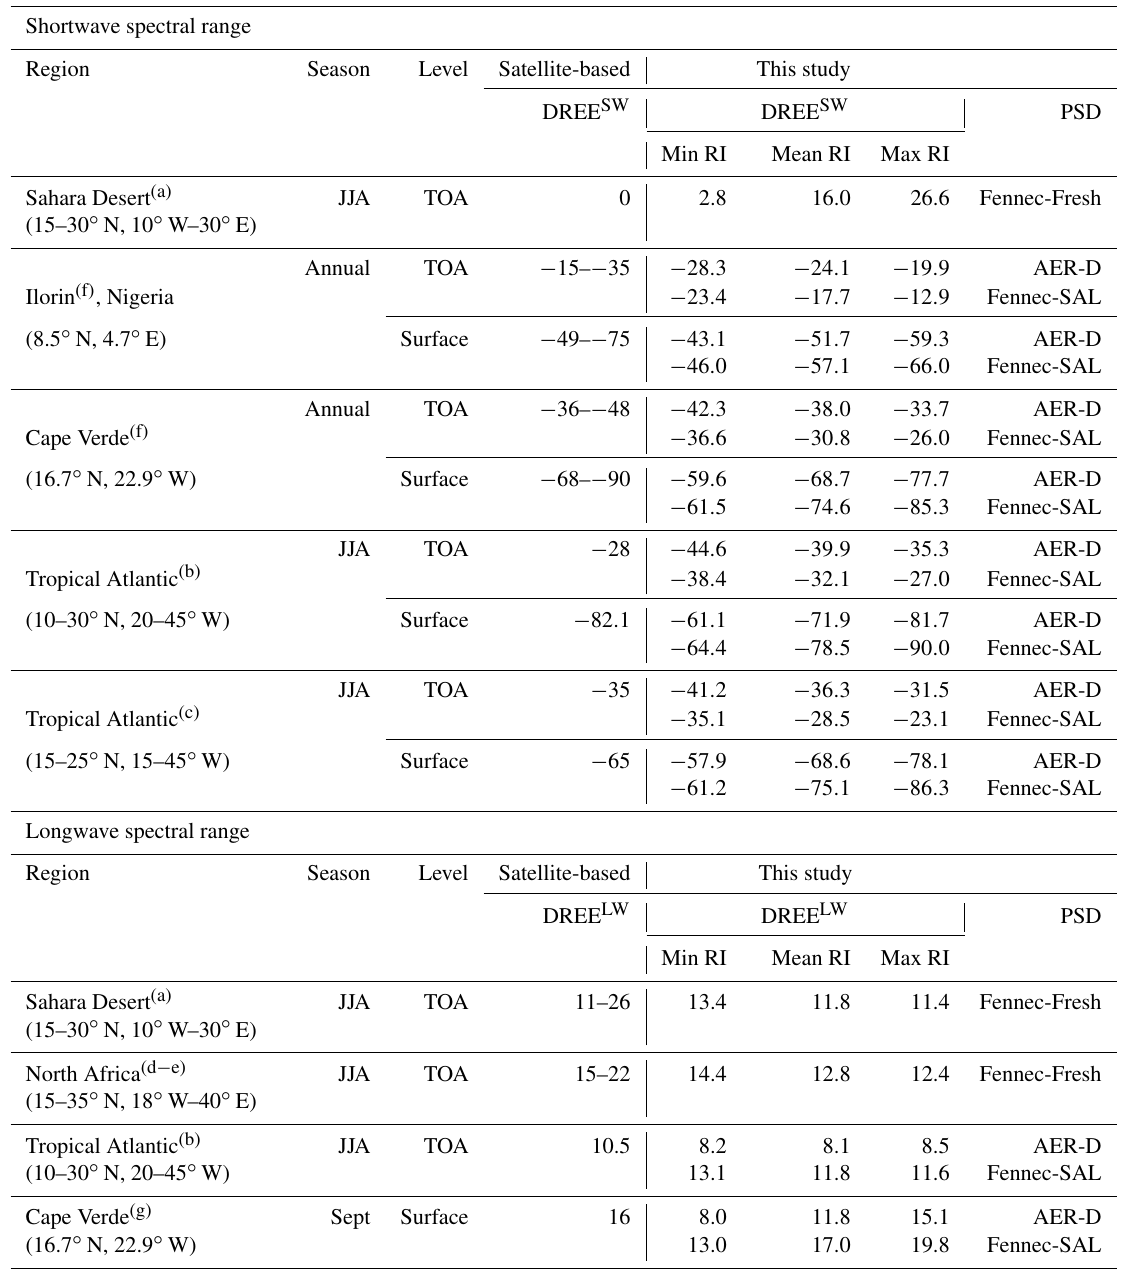
Table 3. Comparison of our DREE estimations for different PSD and RI with clear-sky regional SW and LW dust DREE reported by field studies based on satellite and ground-based observations. Specifically, we calculated regional dust DREE for different RI (Min, Mean, Max) and different PSD (AER-D and Fennec-SAL for tropical Atlantic) and then compared them with observation-based results from previous studies. Note, spheroidal dust shape is assumed in our DREE integration DRE